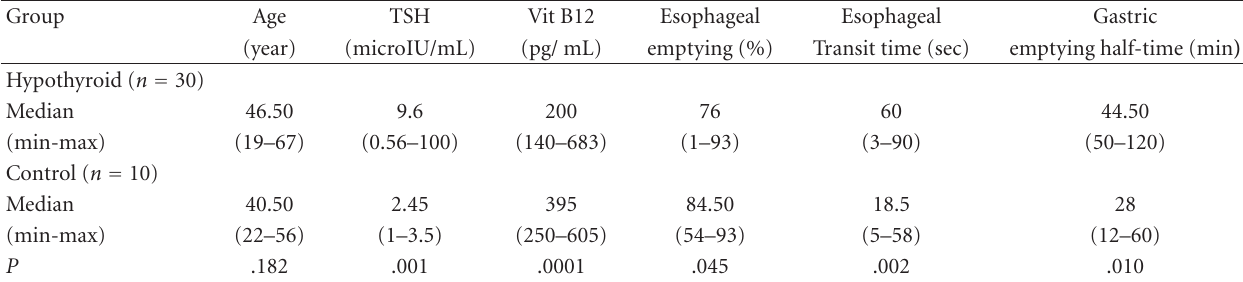
Table 1: The scintigraphic parameters of esophagogastric system and statistical analysis in hypothyroid patients and control